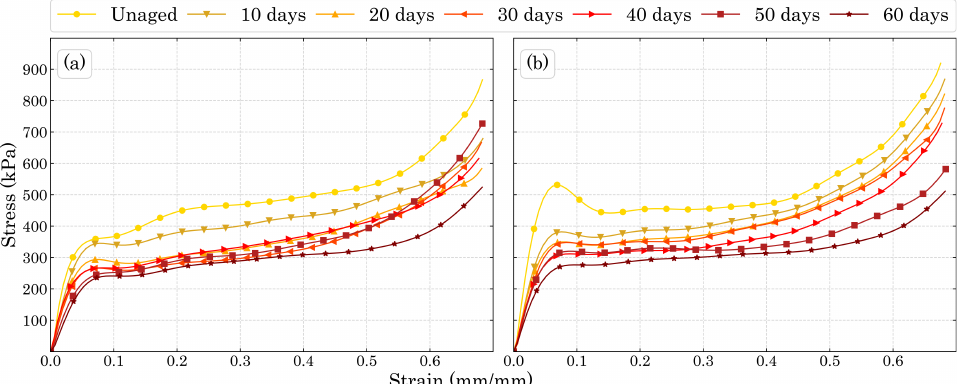
Figure 8. Compression stress-strain curves for ( a ) Dir3 and ( b ) Dir1.